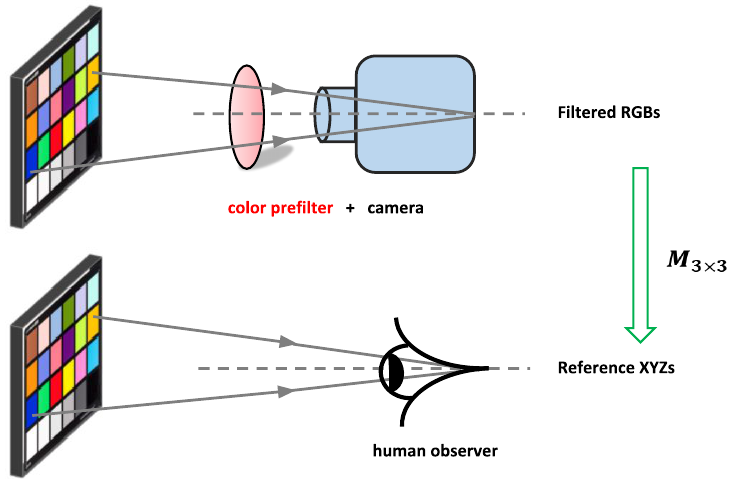
Figure 1. We propose to apply a prefilter for a digital camera such that its filtered RGBs can be best correct to the reference XYZ